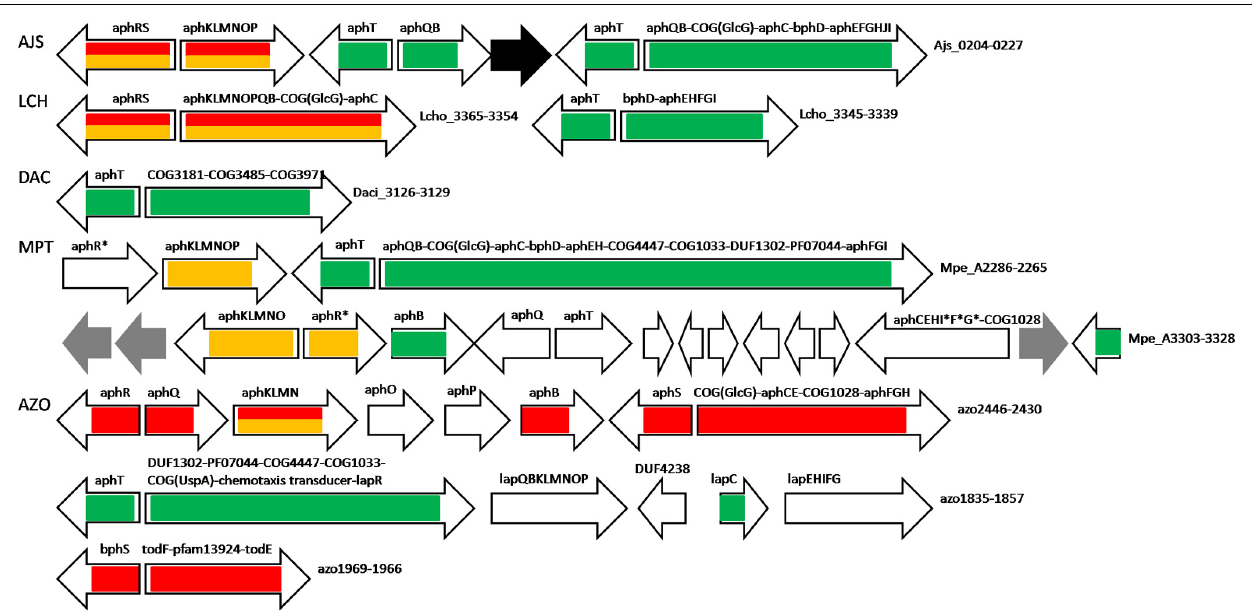
FIGURE 4 | Operon organization and regulation of aromatic metabolism genes regulated by AphS/BphS, AphR, and AphT in other Comamonadaceae and Azoarcus sp. BH72. Color denotes regulation by the following TFs: AphS/BphS – red, AphR – orange, AphT – green. Double coloring denotes dual regulation. Genes/operons are shown by arrows, black arrows denote pseudogenes, gray – transposases. Genome abbreviations as in Supplementary Table S2